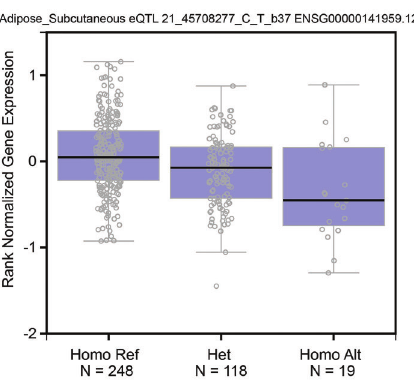
Figure 1. Proteins interacting with autoimmune regulator (AIRE). Homo ref: CC; Het: CT; Homo Alt: TT.